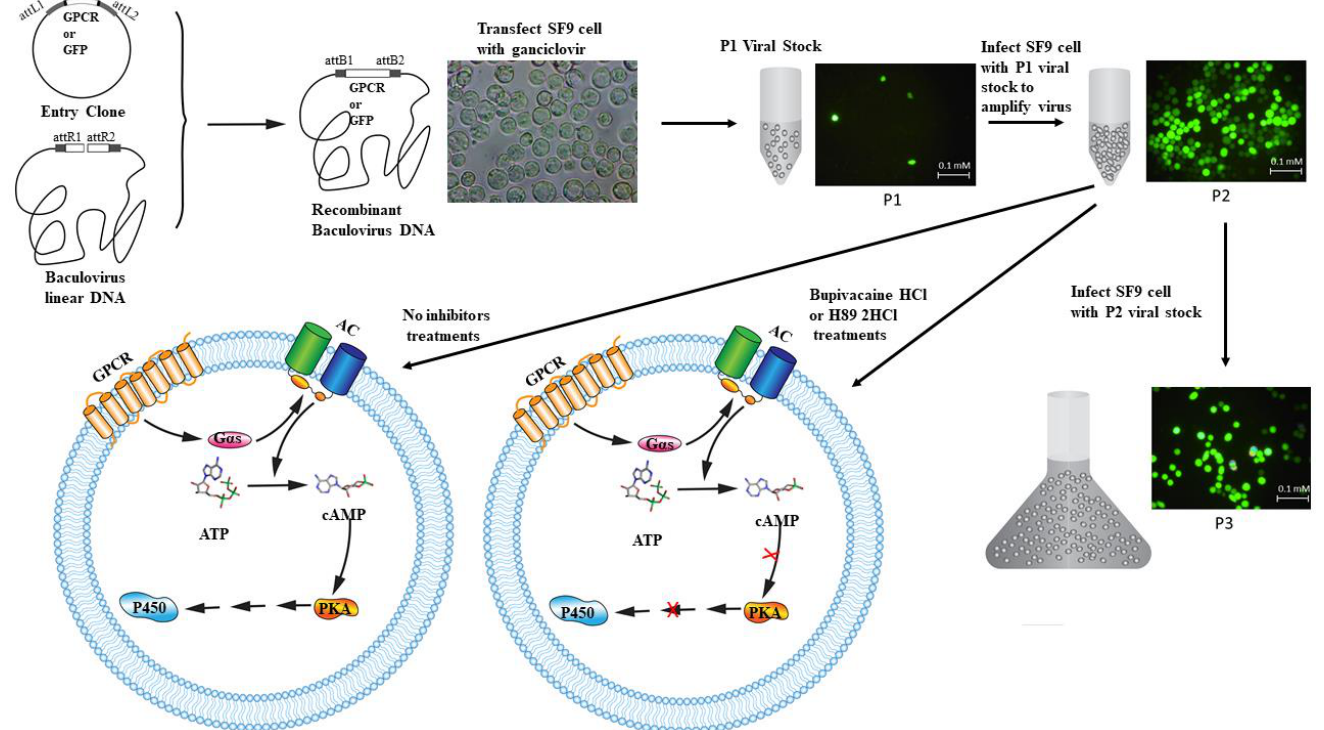
Figure 4. Functional study of GPCR-leading regulation pathway via recombinant baculovirus-GPCR or GFP expression in Sf9 cells. A rhodopsin-like GPCR from the Culex mosquito or a GFP gene was constructed in pENTR TM plasmid and then recombined with BaculoDirect Linear DNA to form a recombinant baculovirus of GPCR or GFP, expressed in insect Sf9 cells. The recombinant baculovirus gene in the Phase 1 (P1) stage serves as the stock solution for virus amplification in Phase 2 (P2), in which GFP expression visually indicates that cells are alive and active, and thus suitable for use in gene functional studies [174]. The P2 virus continues to be amplified to Phase 3 (P3), which is retained as the final stock solution. A hypothesized GPCR-leading intracellular pathway has been determined for the recombinant virus-GPCR expression cells in P2. In these GPCR expression cells, PKA activity, cAMP production, and Sf9 cell P450 gene expression can be examined after treatment with PKA activity inhibitor (H89 2HCl) or cAMP production inhibitor (Bupivacaine) for comparison with non-treated cells. Declining PKA activity and cAMP concentration, and the decreased expression of P450 genes confirm the involvement of the GPCR-leading pathway in insecticide resistance in vitro.